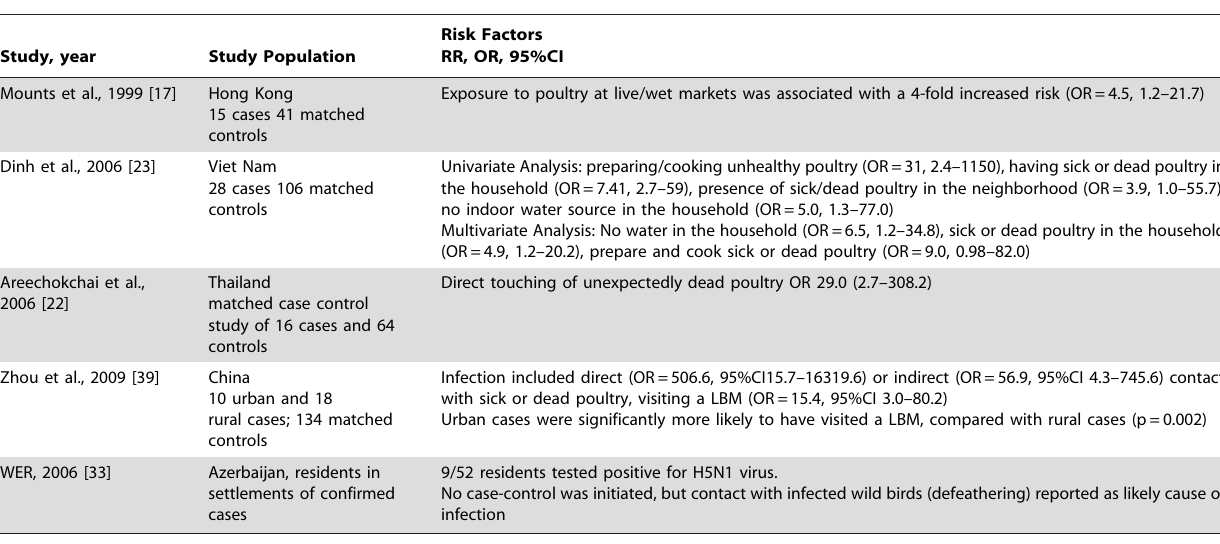
Table 2. Risk factors for H5N1 infection: Summary of published case-control studies.